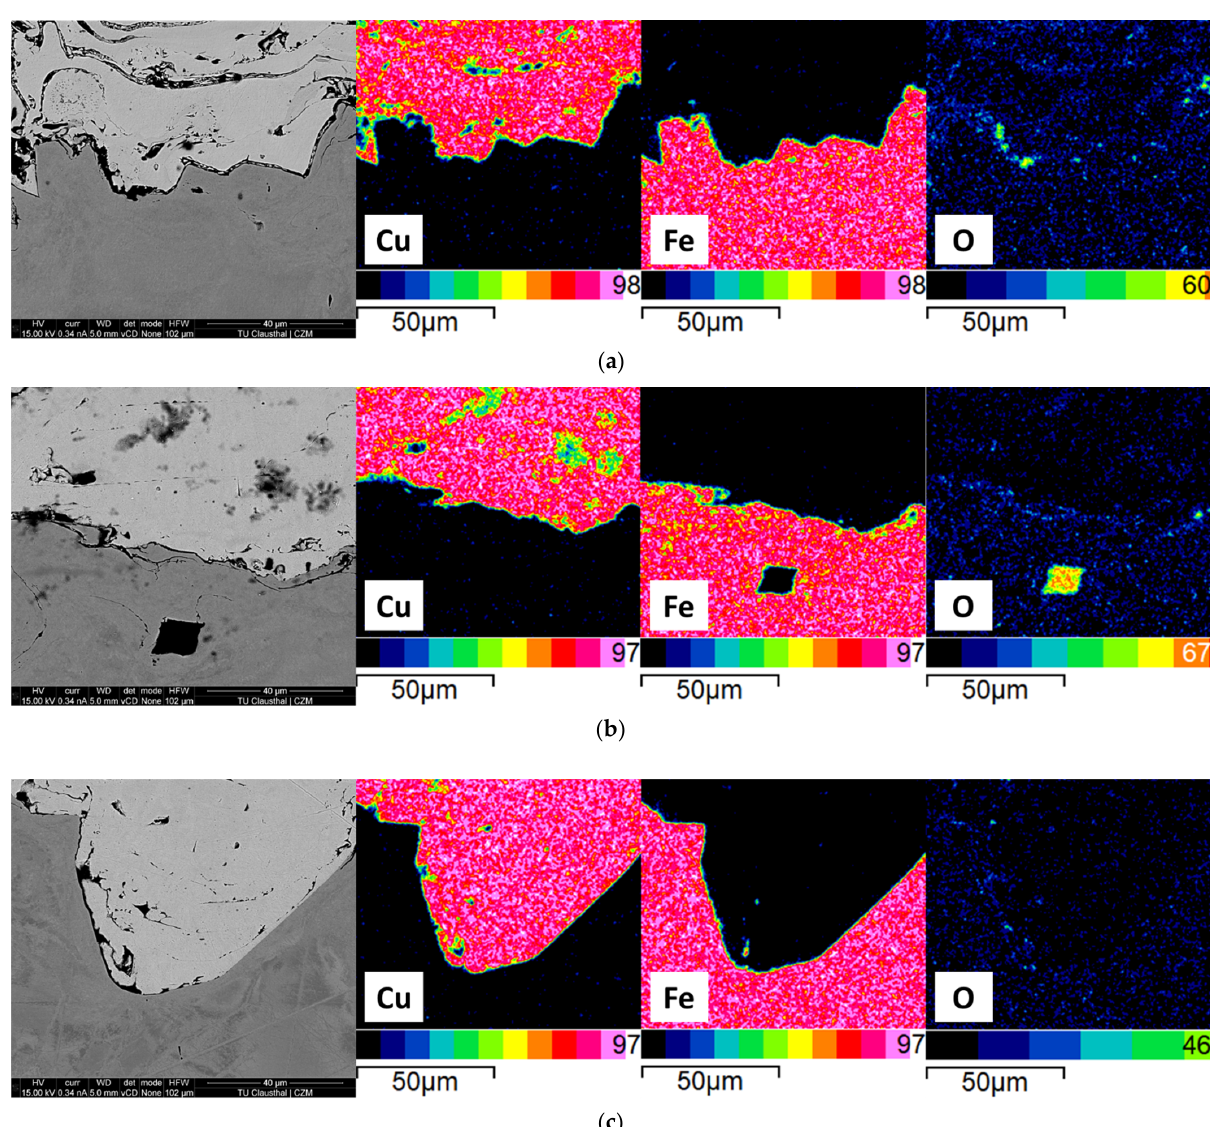
Figure 6. SEM micrographs and quantitative EDS mappings of cross sections from copper coatings, which were ( a ) blasted and coated in air, ( b ) blasted in air, coated in the XHV ‐ adequate environment, and ( c ) blasted and coated in the XHV ‐ adequate environment. EDS scales in atomic percent.